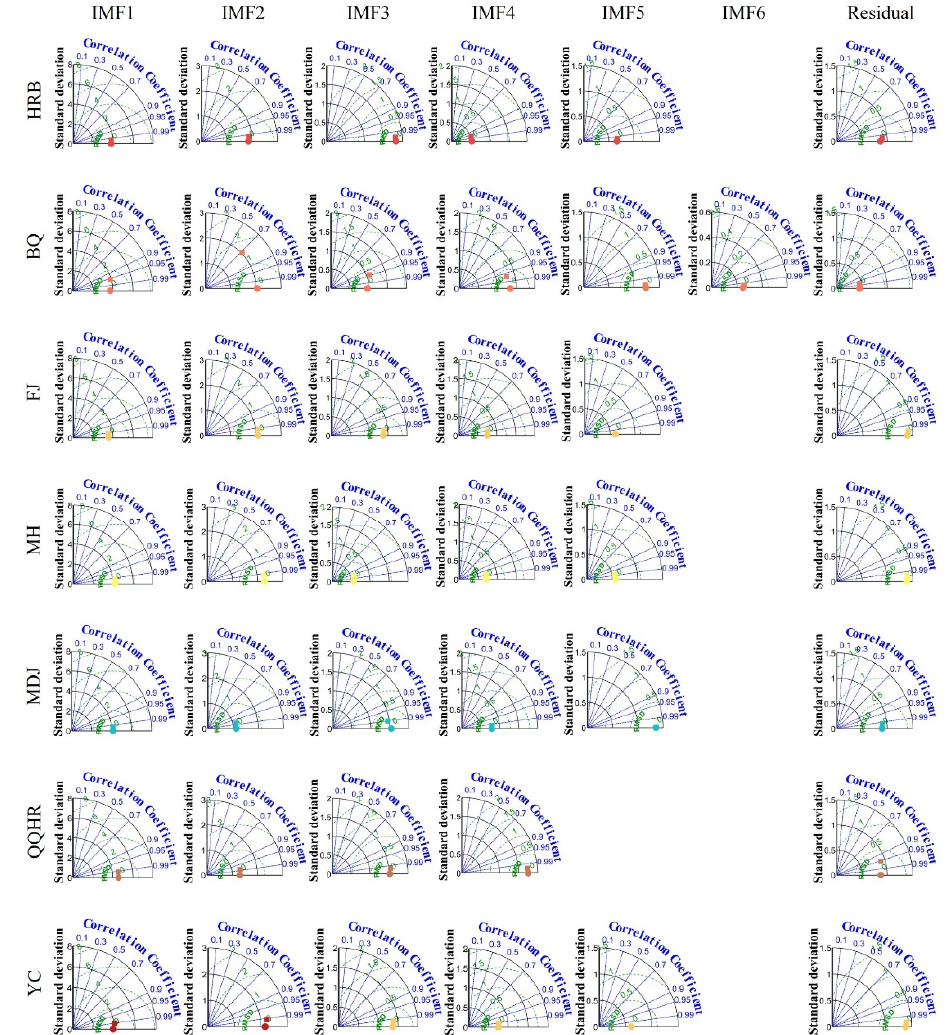
Figure A1. The Taylor diagram of each subsequence at each station.